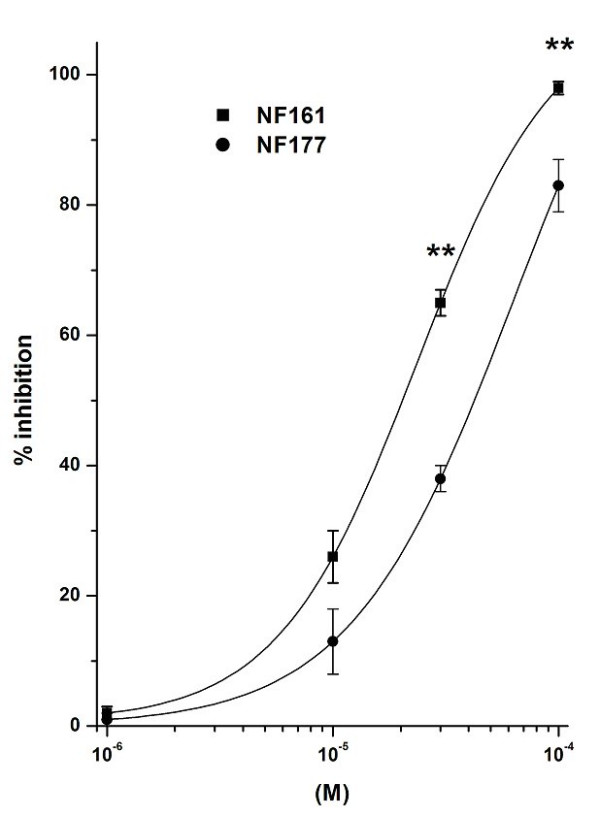
Effects of NF161 and NF177 on FMLP-evoked O2-. production by PMNs. The results are expressed as percentage inhibition of O2-. production evoked by 10-7M FMLP in the absence of NF161 and NF177: this production amounted to 2.1 ± 0.3 nmol cytochrome C reduced/106 cells/min and was taken as 100%. Data are expressed as means ± SEM; n = 5. Asterisks mark statistically significant inhibition of NF161 versus NF177 (**P < 0.01).